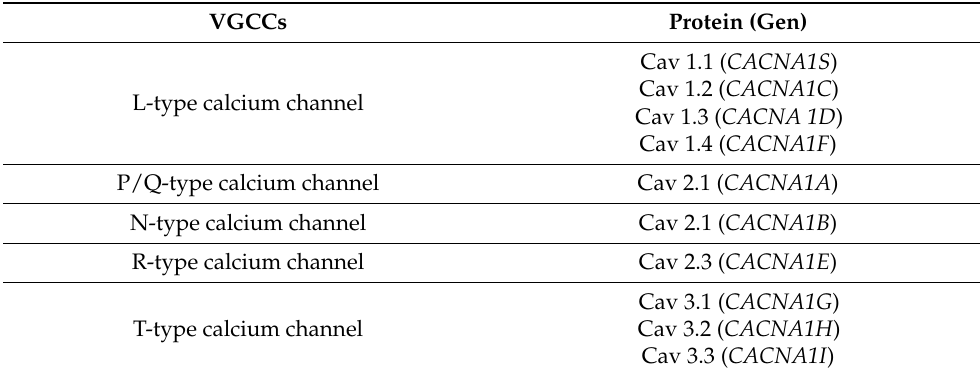
Table 3. Summary of voltage gated calcium channel (VGCC) isoforms: list of genes that codifies the different proteins that constitute the VGCCs